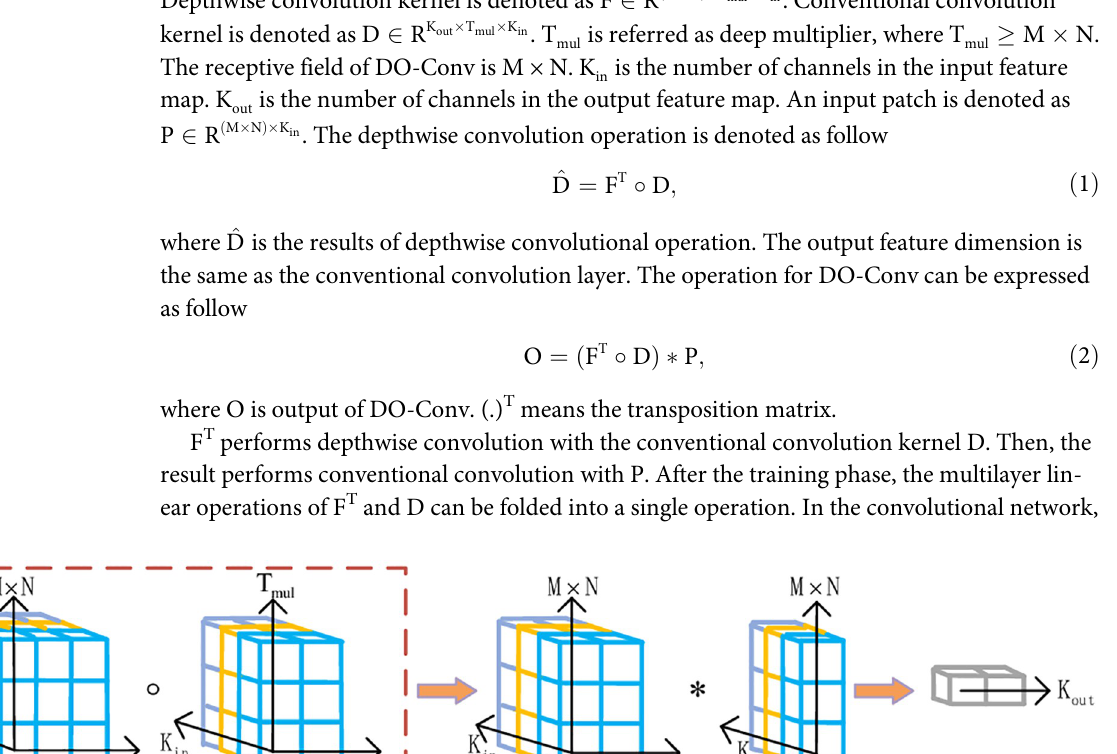
PLOS ONE | https://doi.org/10.1371/journal.pone.0273690 August 31,